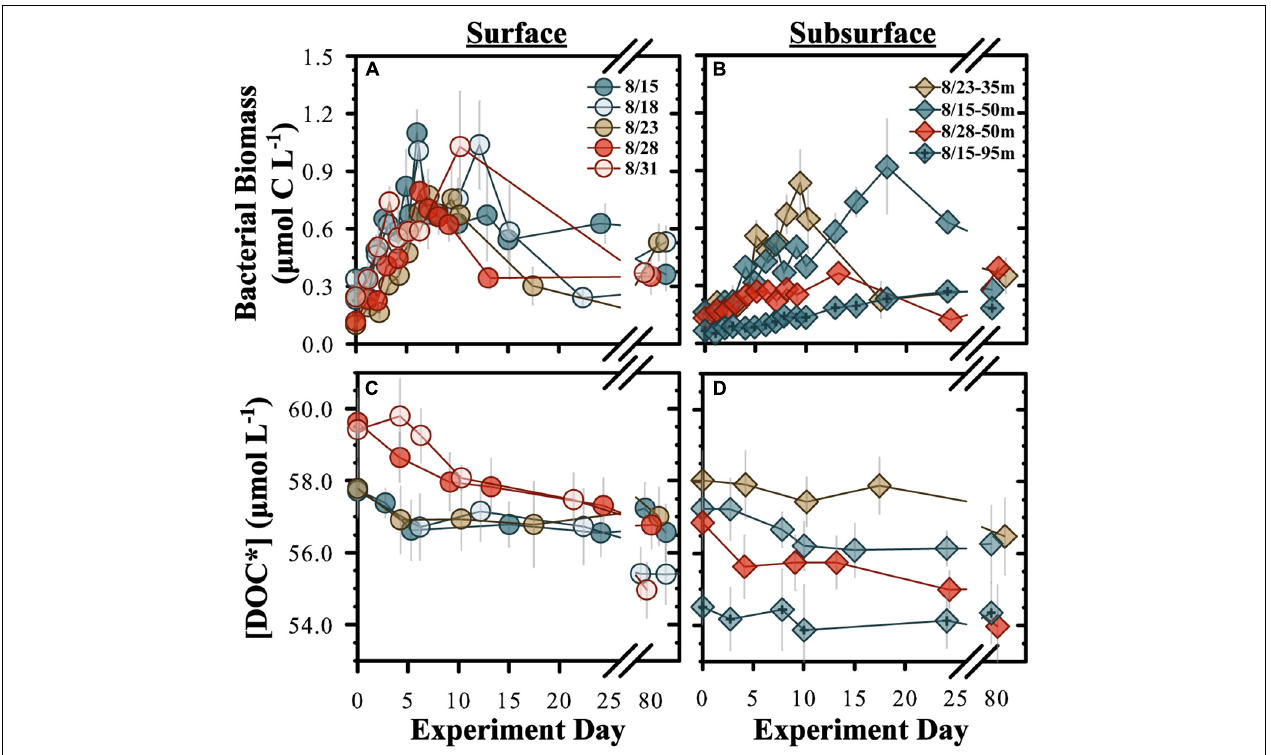
FIGURE 1 | Temporal changes for “diluted” OM remineralization experiment bacterioplankton biomass (A,B) and [DOC*] (C,D) . “Surface” (A,C) refer to experiments conducted from 5 m and “subsurface” (B,D) refers to experiments conducted at 35, 50, and 95 m. DOC* denotes that concentrations were corrected for bacterioplankton carbon but contain an unconstrained contribution of C < 3.0 µ m. Incubation start dates are